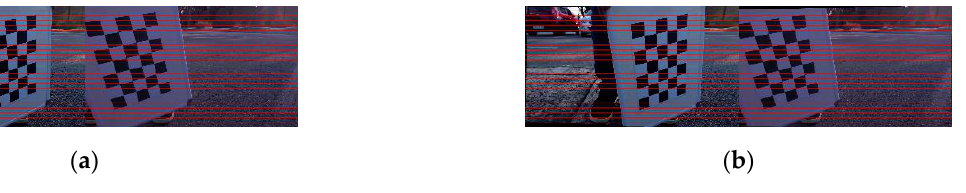
Figure 4. Image rectification: ( a ) the input image, ( b ) the output